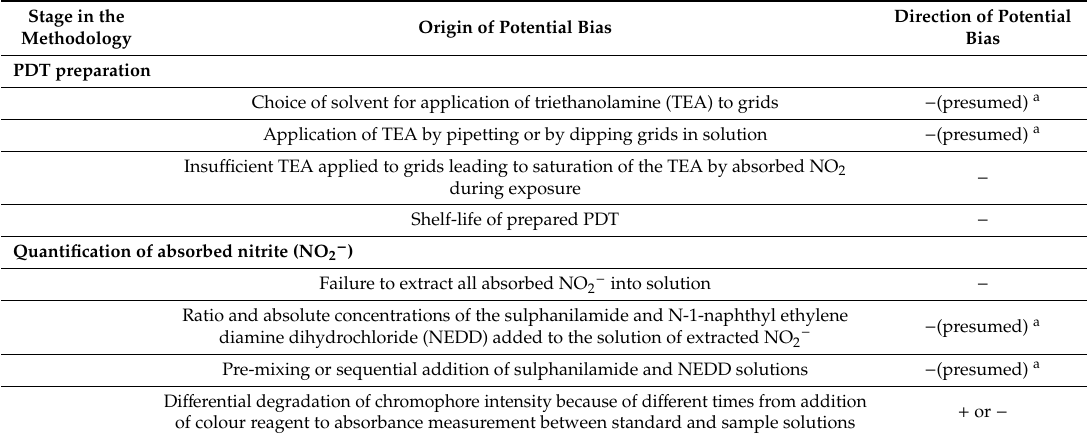
Table 1. Potential factors influencing accuracy of quantification of ambient NO 2 by passive di ff usion tube